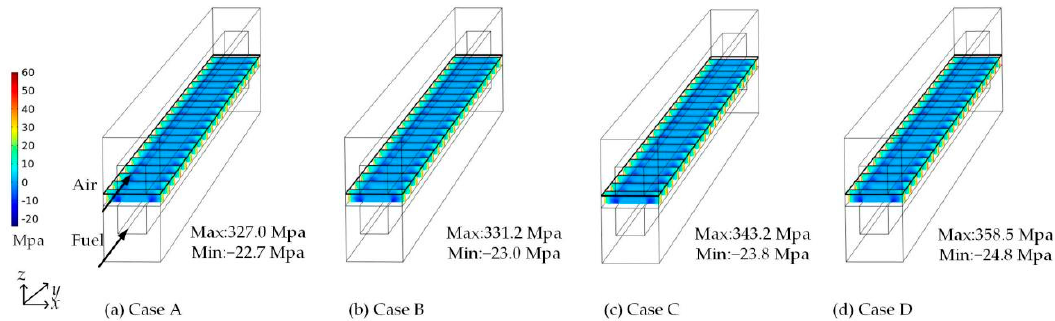
Figure 8. Distribution of the first principal stress under different methane Pre-Reforming percentages.